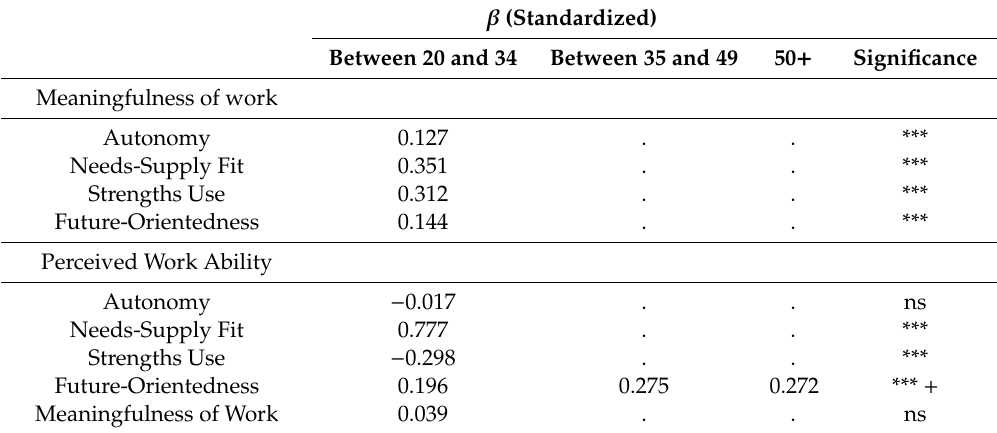
Table 4. Final model standardized e ff